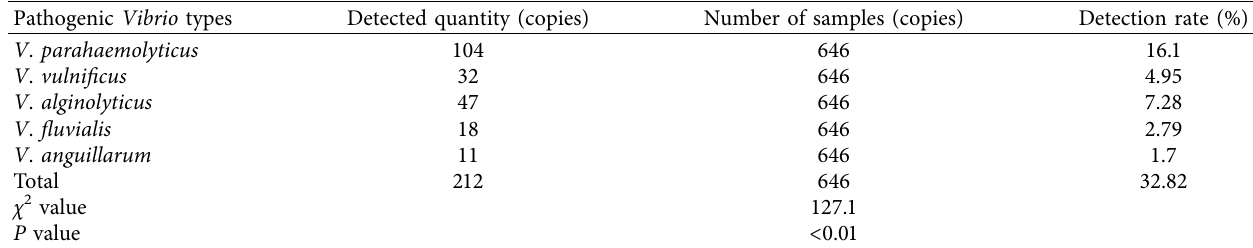
Table 6: Detection of different types of pathogenic Vibrio in aquatic products.